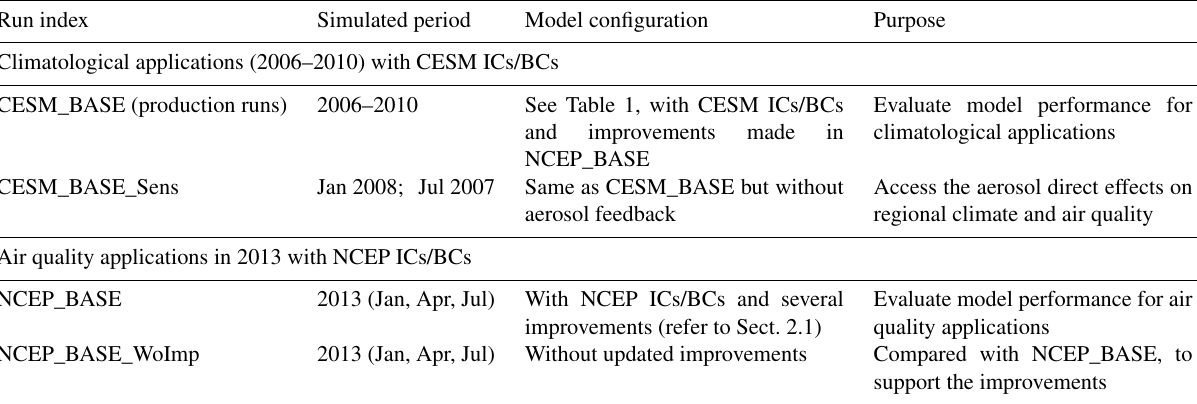
Table 2. Simulation design. Run index Simulated period Model configuration